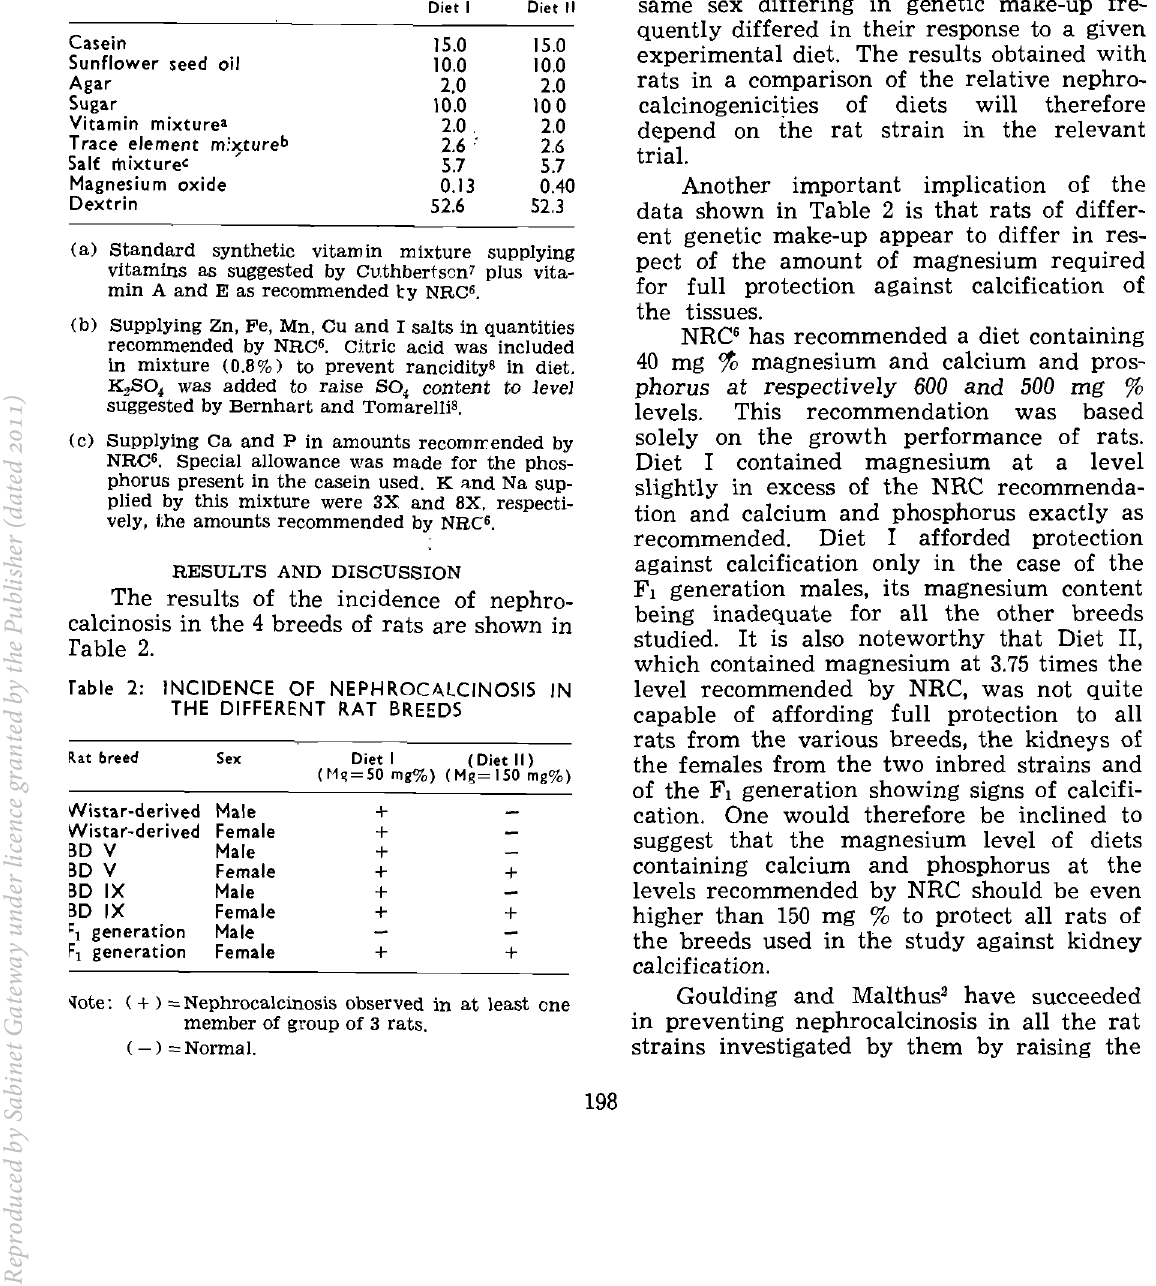
Table 1: CONSTITUENTS ·OF EXPERIMENTAL DIETS Constitueilt